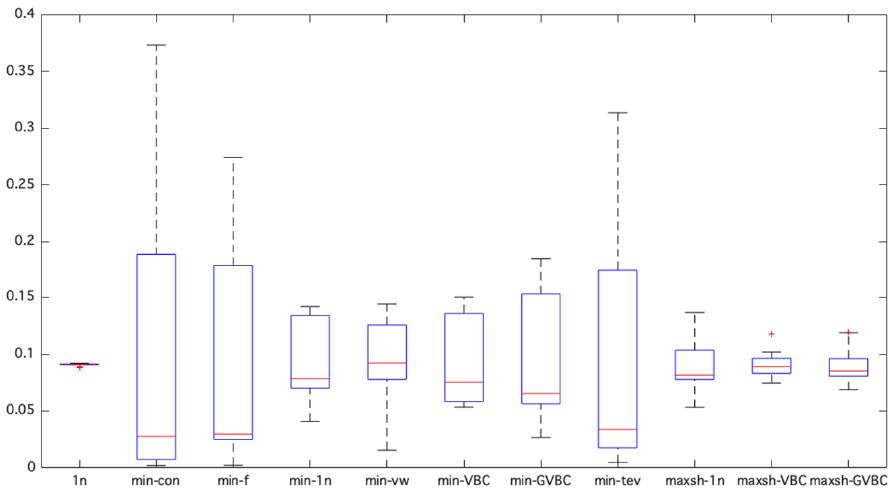
Figure 3. Weights concentration of long-only strategies.